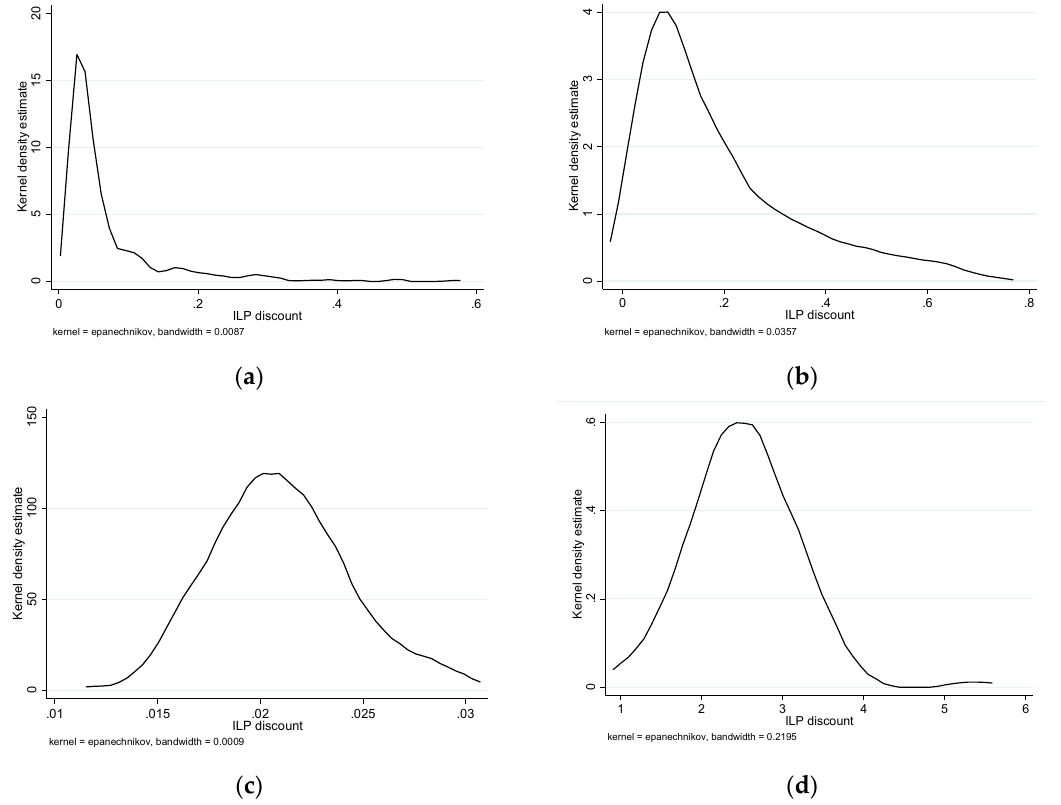
Figure 2. Kernel density estimates of individual-level discount parameters by respondent group. ( a ) Respondents without dominant strategy; ( b ) respondents who never chose the status quo but not always the maximum discount; ( c ) respondents who always chose the status quo; ( d ) Respondents who always chose the maximum discount.